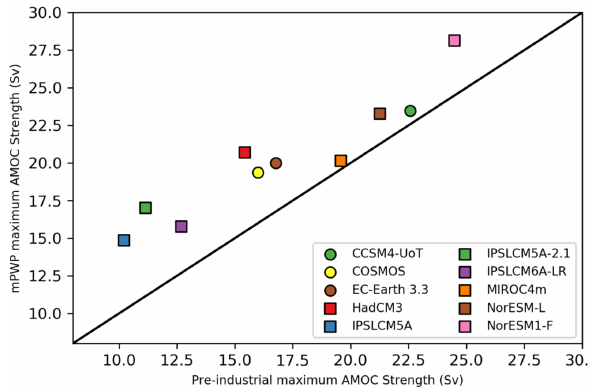
Figure 12. Maximum pre-industrial and mPWP AMOC strength (Sv). The black line indicates equal pre-industrial and mPWP max- imum AMOC